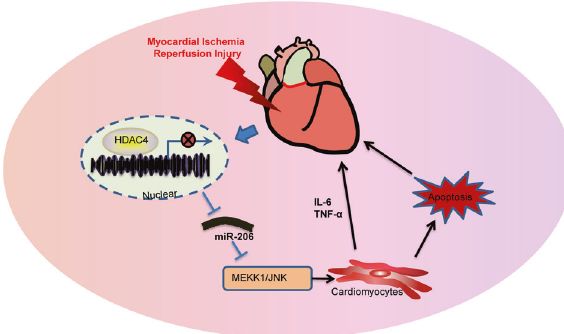
Fig. 6 The mechanistic diagram. HDAC4 down-regulates the expression of miR-206 to promote cardiomyocyte apoptosis and oxidative stress, thereby inducing MIRI by activating MEKK1/JNK